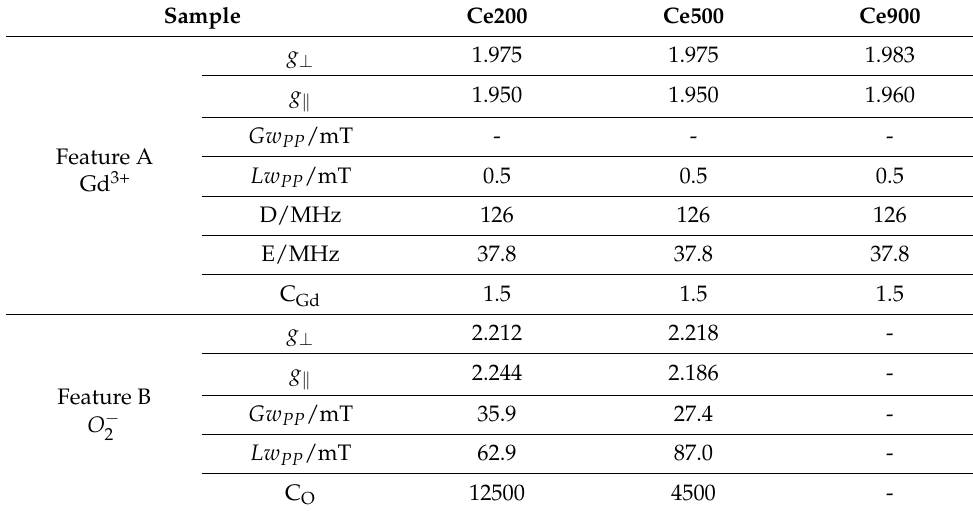
Table 3. Parameters adopted to fit the ESR spectra. Gw pp and Lw pp are FWHM of the Gaussian and Lorentian contributions to peaks broadening; D and E are zero field splitting parameters; and C Gd and C O are the multiplicative (scale) coefficients introduced in EasySpin for Gadolinium and Oxygen species,